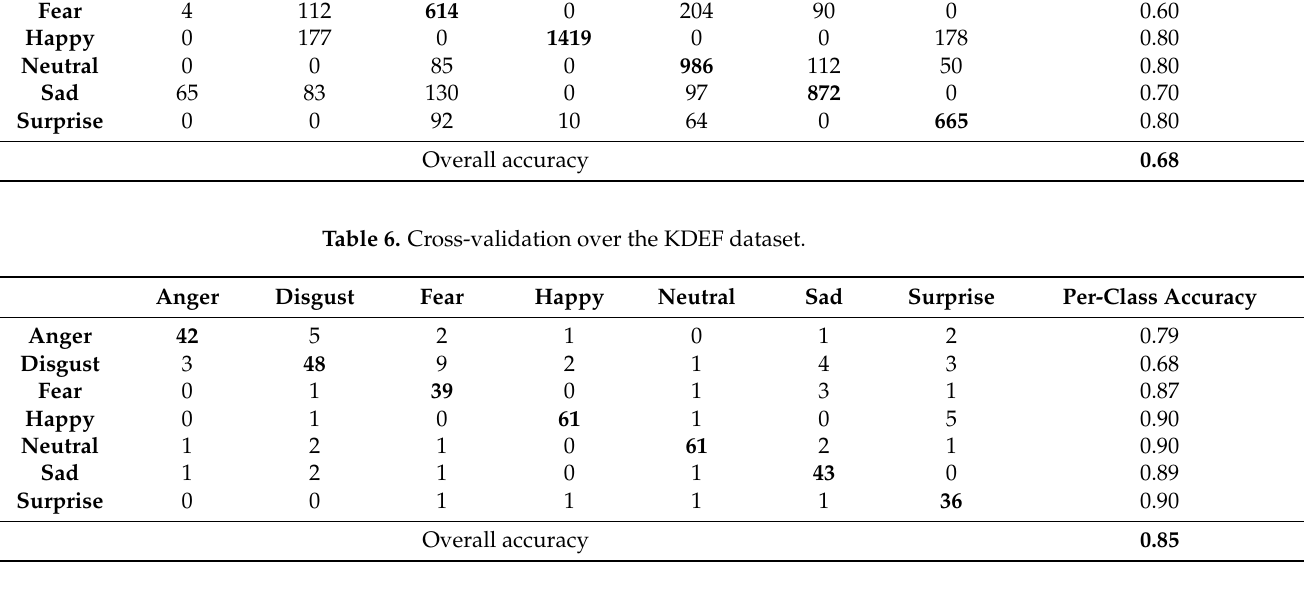
Figure 6. Confusion matrix of the proposed model over the CK+ dataset.